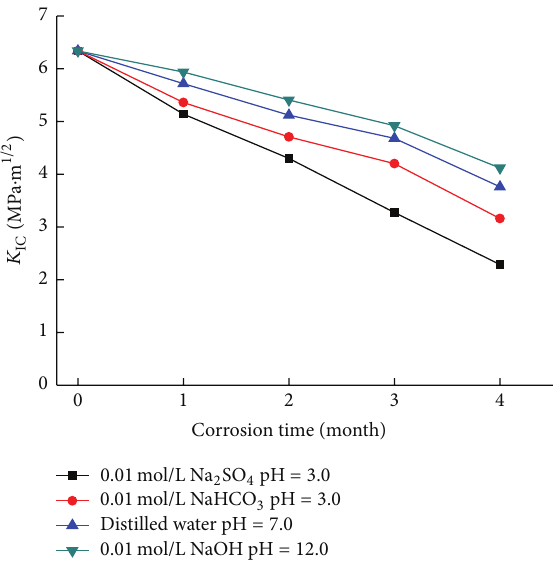
Figure 5: Relationship between 𝐾 IC of granite specimens and corrosion time under different water chemical